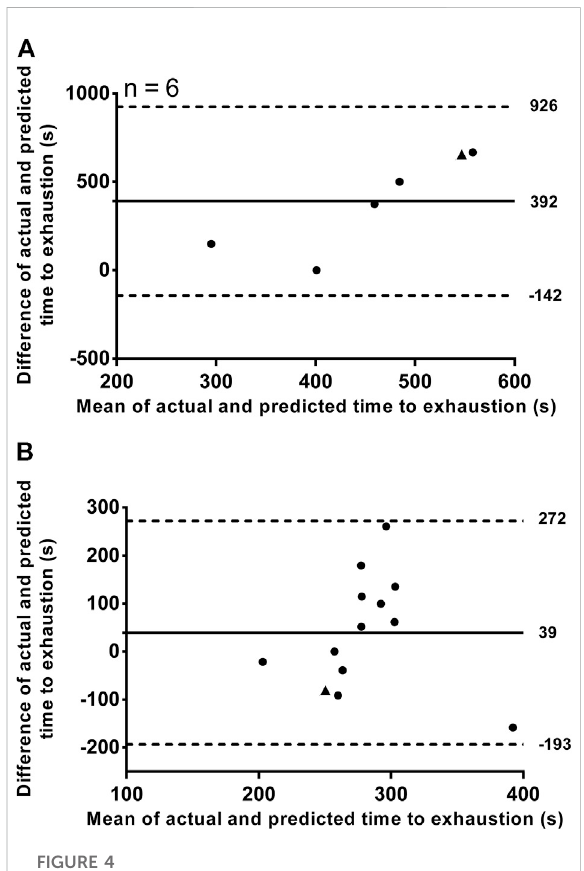
Bland – Altman plots showing individual differences between actual and predicted time to exhaustion plotted against their individual mean values. Training sessionswith a work/relief ratio of 2:1 (A) and with a work/relief ratio of 4:1 (B) . Horizontal solid line represents the mean difference and while horizontal dashed lines represent the 95% limit of agreement. ▲ represents the swimmer 11(see result section for bias and 95% limit ofagreement analyses without this